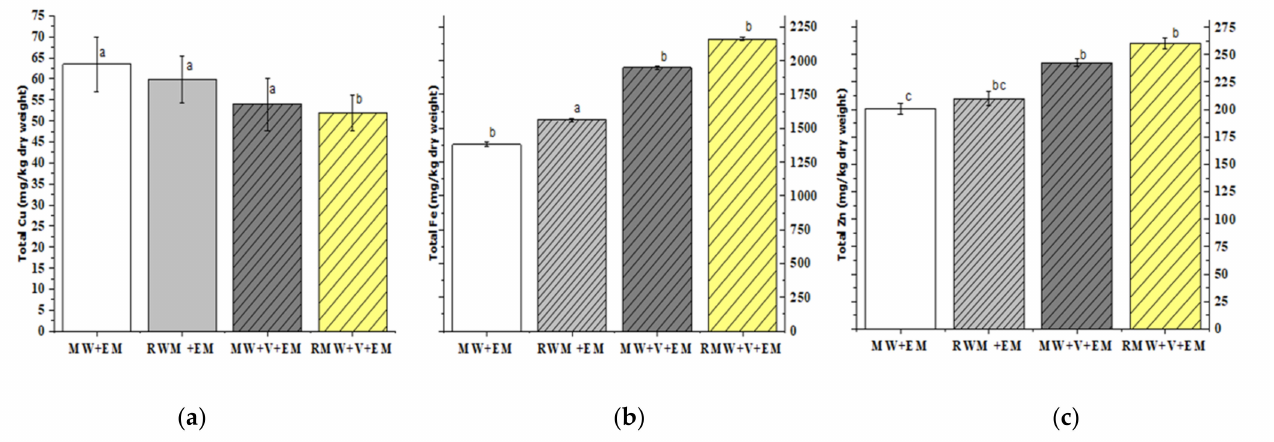
Figure 8. The total concentrations of Cu ( a ), Fe ( b ), and Zn ( c ) of [MW+EM], [RMW+EM], [MW+V+EM], and [RMW+V+EM]. Error bars represent the standard errors for six samples. Columns followed by the same letter do not differ significantly (ANOVA; Tukey’s test, p < 0.05).